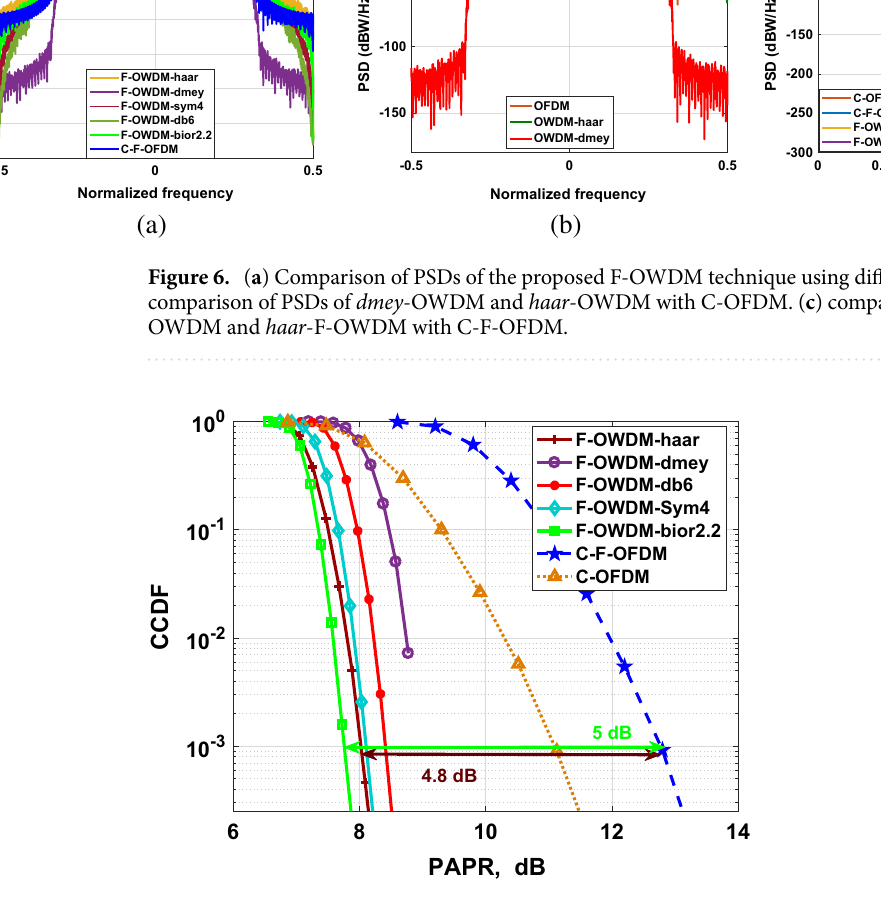
Figure 7. Comparison of PAPRs of F-OWDM with C-F-OFDM and C-OFDM using 4-QAM